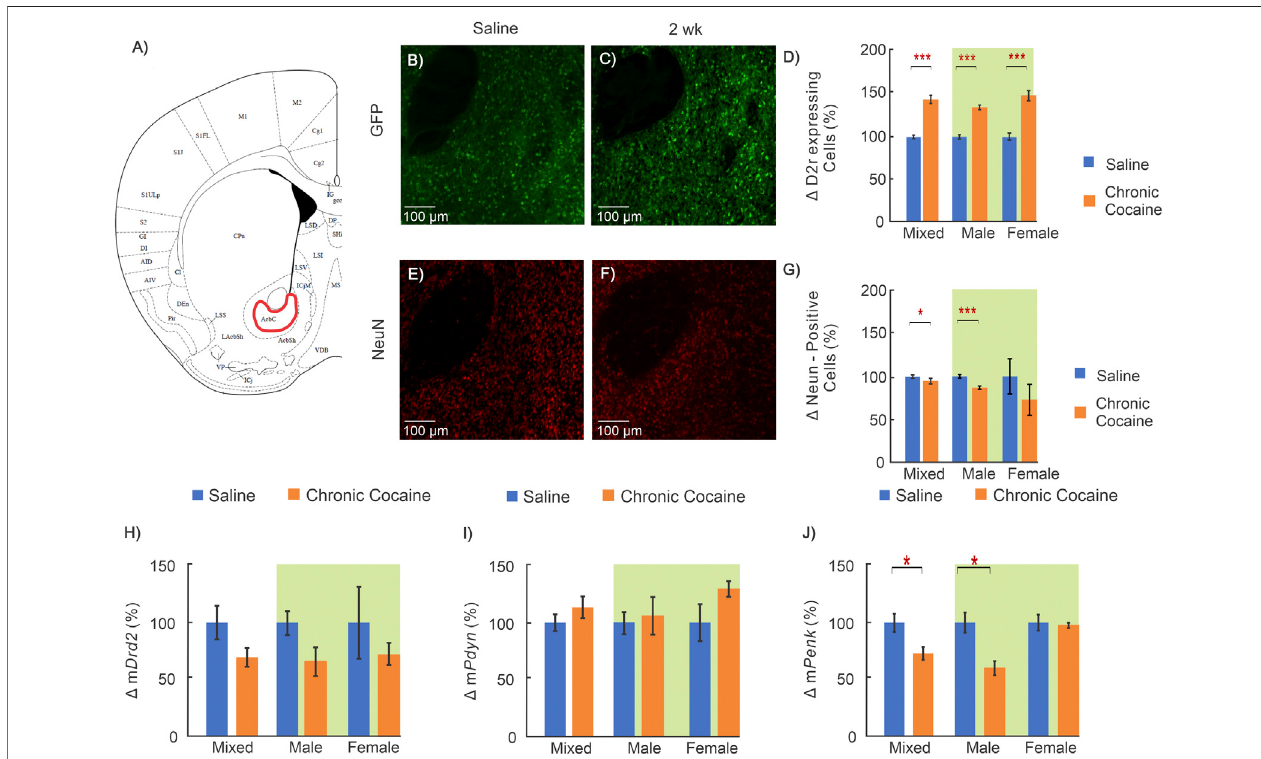
FIGURE5| Effectsofcocaineinnucleusaccumbens(NAc). (A) :BrainatlasofthelocationinNAcwhereimageswereobtained(GeorgeandFranklin,2001); (B,E) : “ Zoom-in ” GFP and NeuN sections in NAc for a representative control; and (C, F) : for a representative cocaine mouse; (D) Results comparing D2r-GFP expressing neuronsinNAcforsaline(blue,n (cid:2) 12;5 \ ,7 _ )andcocaineexposedmice(orange,n (cid:2) 11;6 \ ,5 _ );and (G) :resultsfordifferencesintotalneurons(saline (cid:2) 11;5 \ ,6 _ , cocaine (cid:2) 10; 6 \ , 4 _ ); (H – J) : Results in WT mice comparing mRNA levels for (H) : Drd2 , (I) : Pdyn and (J) : Penk between saline (blue, n (cid:2) 12; 6 \ ,6 _ ) and cocaine treated (orange, n (cid:2) 14; 7 \ ,7 _ ) animals. Mixed: including both male of female; female: female animal only; male: male only; Two-way ANOVA data indicated with green background; *: p < 0.05; **: p < 0.005; ***: p <